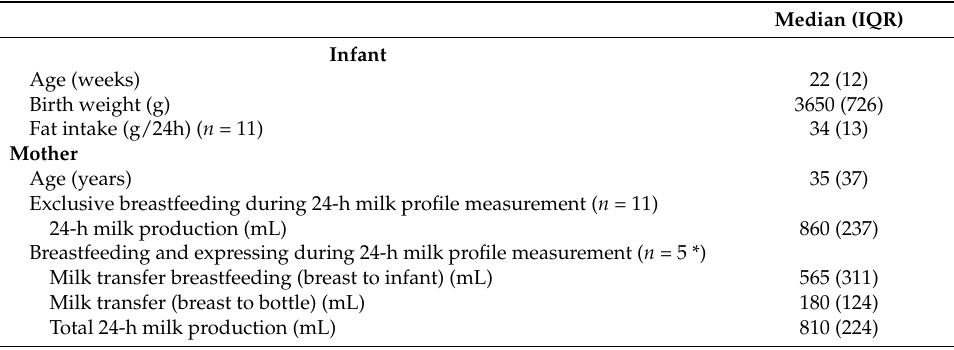
Table 1. Demographics of participants ( n = 15).